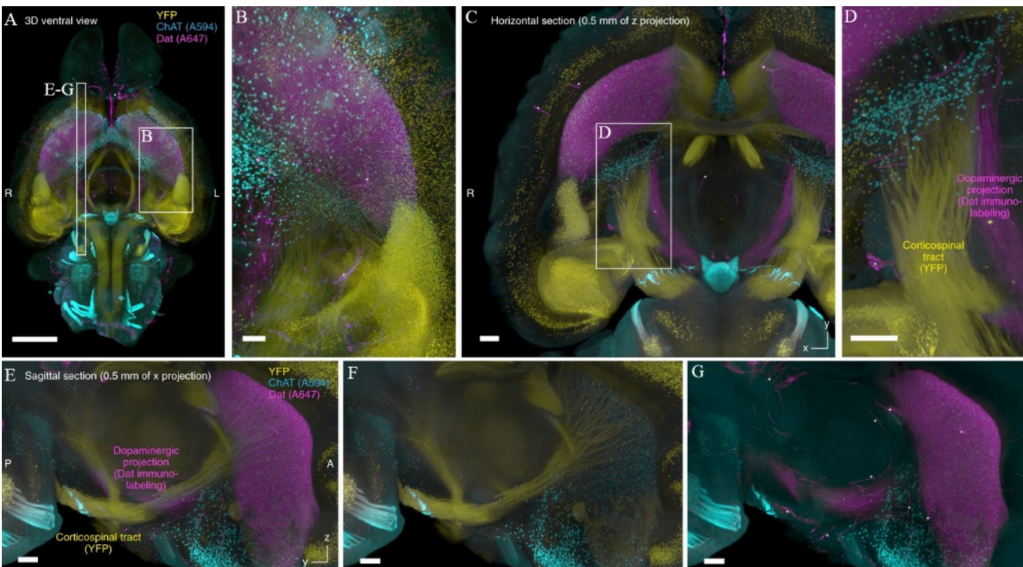
Figure 6. CUBIC-HistoVIsion approach allows for the efficient immunolabeling of the entire mouse brain. ( A – D ) The entire murine Thy1-YFP-H brain was cleared, stained using CUBIC-HistoVIsion approach and imaged with the voxel size of 8.3 × 8.3 × 9 µ m 3 . The idea that stands behind this pipeline (see the text for details) opens a new way for deep-tissue immunolabeling without the necessity to apply any external forces/apparatus that could potentially lead to sample damage. Images ( E – G ) represent reconstituted sagittal sections at the position indicated in ( A ). Reproduced from Susaki et al. [103] under the terms of Creative Commons CC BY